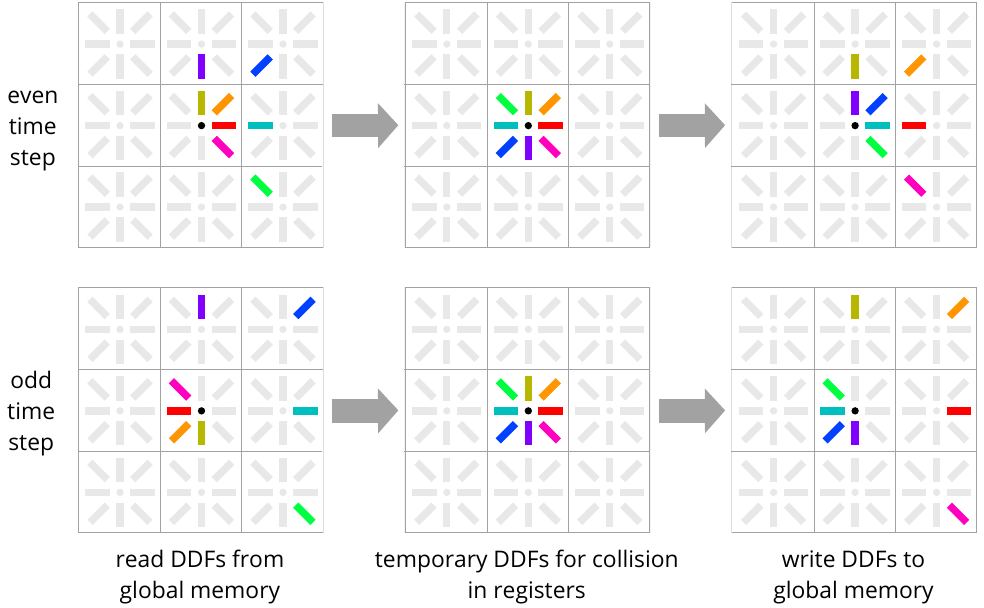
Figure 5. Esoteric Pull in-place streaming scheme. Even time steps: DDFs in positive directions are loaded from the center node, and DDFs from negative directions are pulled in from their regular streaming direction neighbors and are collided. Then, DDFs in positive directions are pushed out to neighbors and stored in opposite orientation, and DDFs in negative directions are stored at the center node in opposite orientation. Odd time steps: DDFs in positive directions are loaded from the center node in opposite orientation, and DDFs from negative directions are pulled in from their regular streaming direction neighbors in opposite orientation and are collided. Then, DDFs in positive directions are pushed out to neighbors, and DDFs in negative directions are stored at the center node. DDFs are always stored in the same memory locations where they were loaded from, so only one copy of the DDFs is